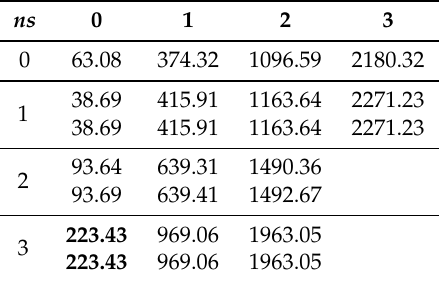
Table 1. Computed natural frequencies, f ns = ω ns /2 π , of the circular plate (with n nodal diameters and s nodal